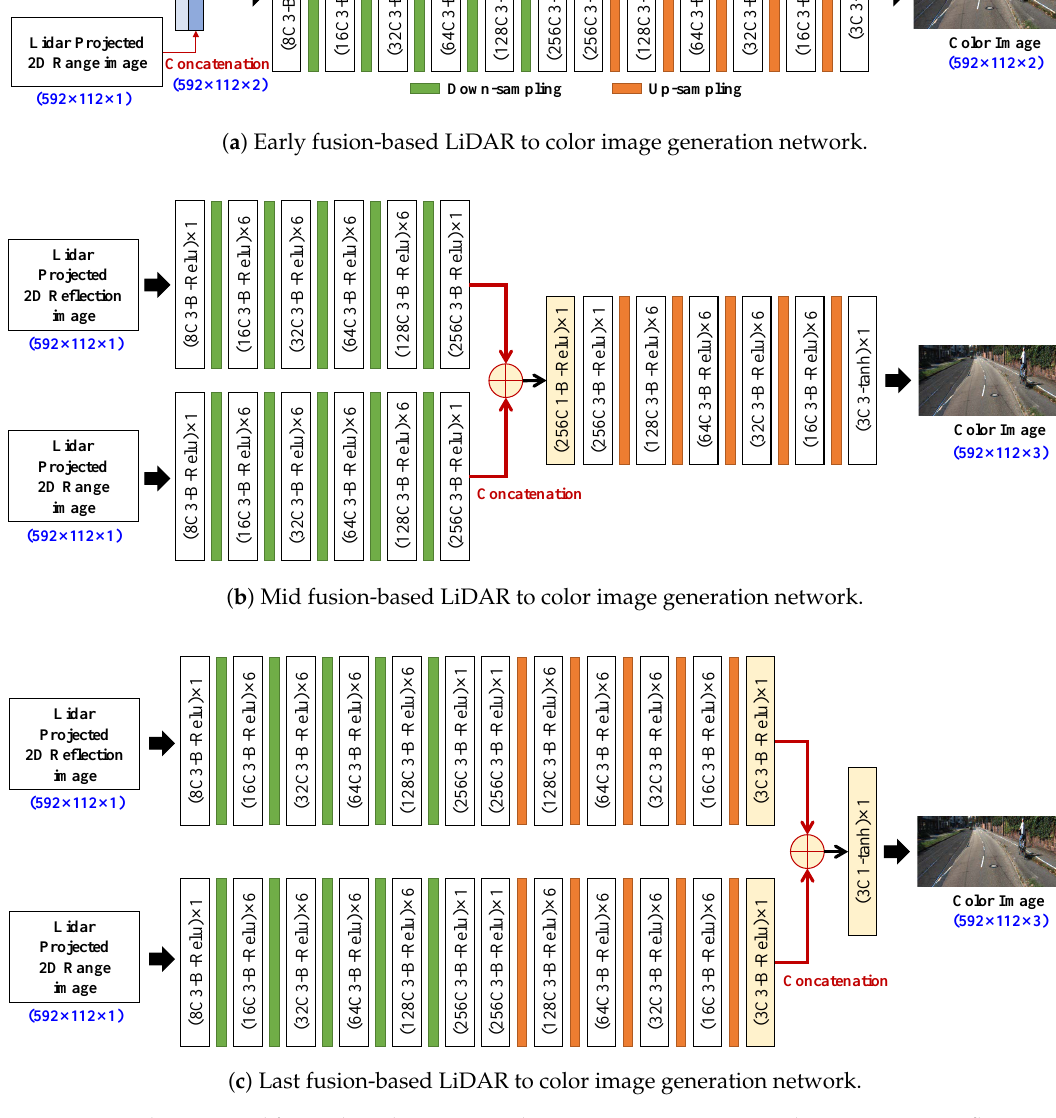
Figure 3. The proposed fusion-based LiDAR to color image generation networks using LiDAR reflection and range data: ( a ) early fusion, ( b ) mid fusion, and ( c ) last fusion-based LiDAR to color image generation